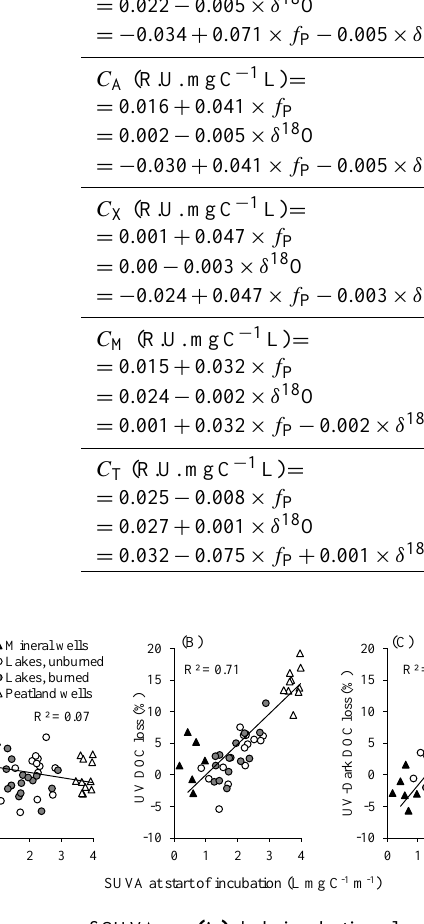
Fig. 8. Influence of SUVA on (A) dark incubations losses (B) UV incubation losses and (C) the difference between UV and dark in- cubation losses. Significant relationships between SUVA and DOC losses were found in all cases, but were weaker for dark DOC losses ( p = 0.045) than for UV or UV–dark losses (both p < 0.001). Production of CO 2 during incubations was correlated with measured DOC losses across all samples ( R 2 = 0.70, p < 0.001), although CO 2 production exhibited less varia- tion, likely due to better measurement precision than for